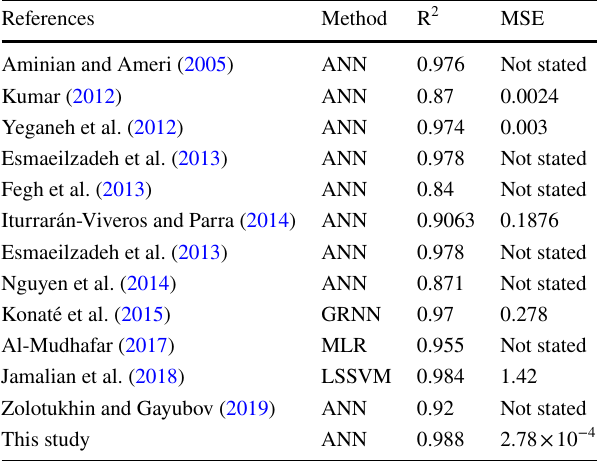
Table 6 Comparison between the developed ANN model and previ- ous AI